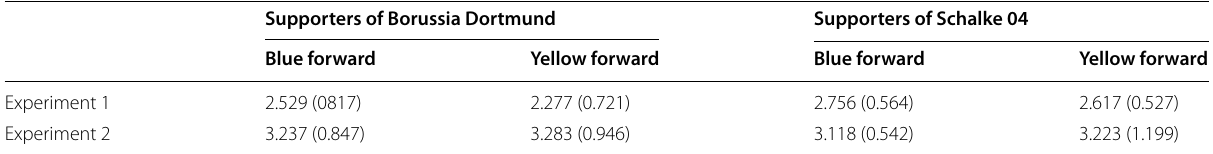
Table 2 Sensitivity index d ′ as observed in Experiments 1 and 2 as a function of group (supporters of Borussia Dortmund vs. supporters of Schalke 04) and attacking team (blue vs. yellow)